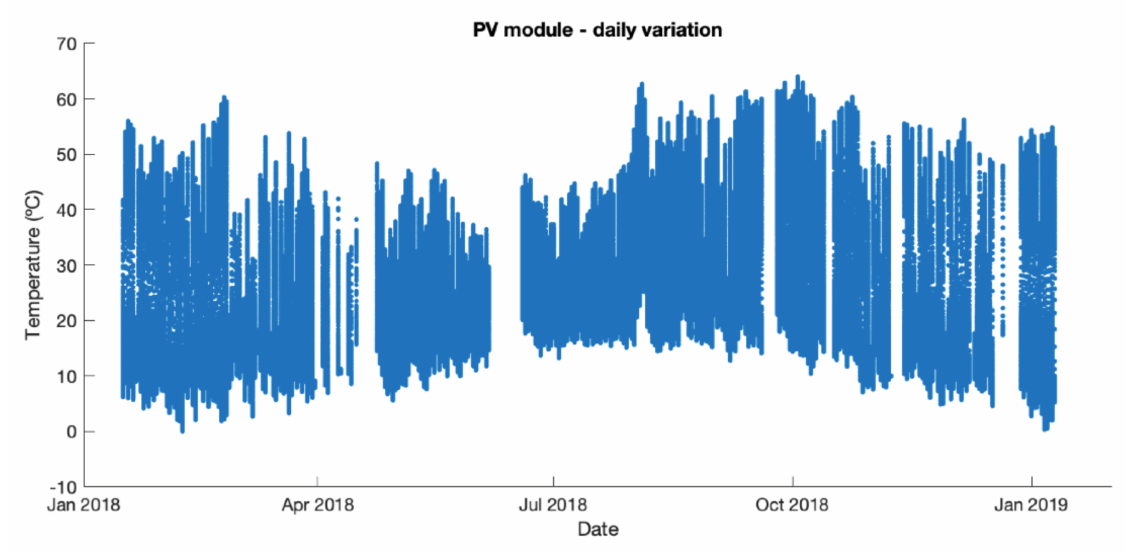
Figure 6. Yearly PV module